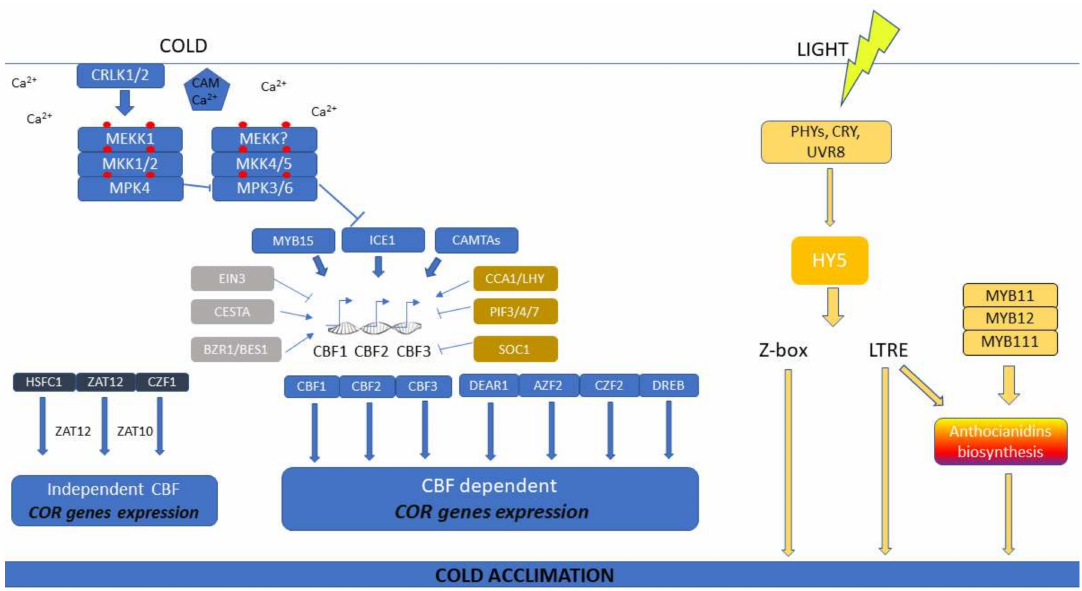
Figure 2. Representation of cold stress signaling, cold genes response, and